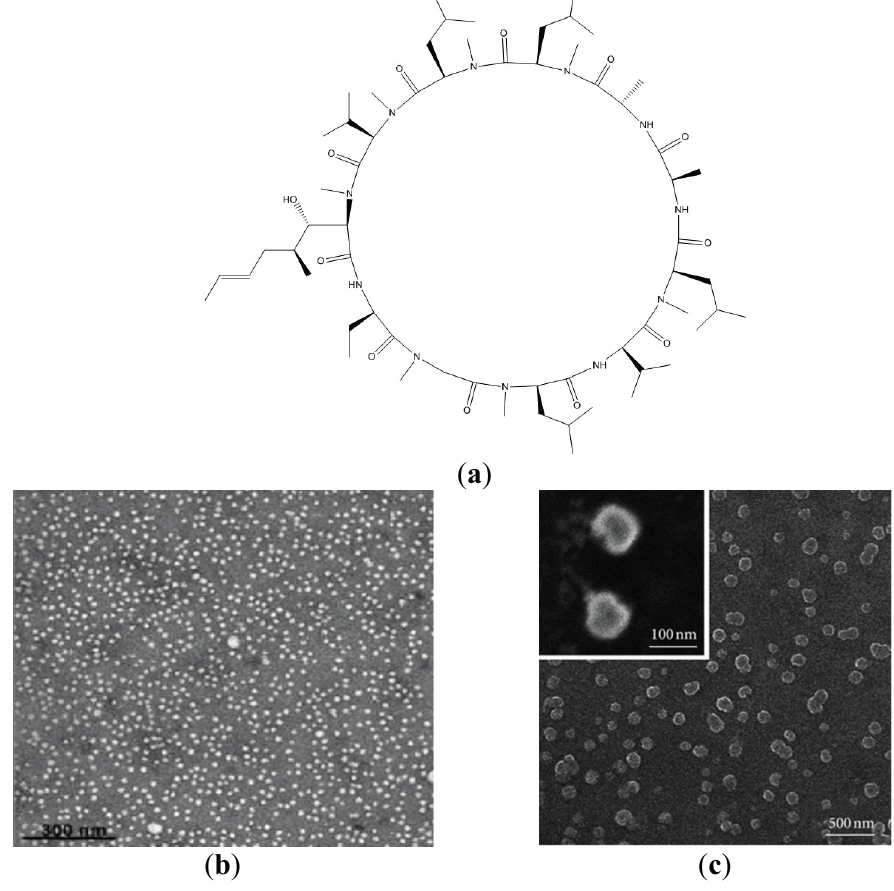
Figure 4. ( a ) The chemical structure of CsA. ( b ) Transmission electron micrographs of polymeric nanometric micelles carrying CsA. The bar corresponds to 300 nm. Adapted from [119] with permission from copyright 2011 Elsevier; ( c ) Scanning electron microscopy of polymeric nanoparticles of PEG-PLGA carrying CsA. Adapted from